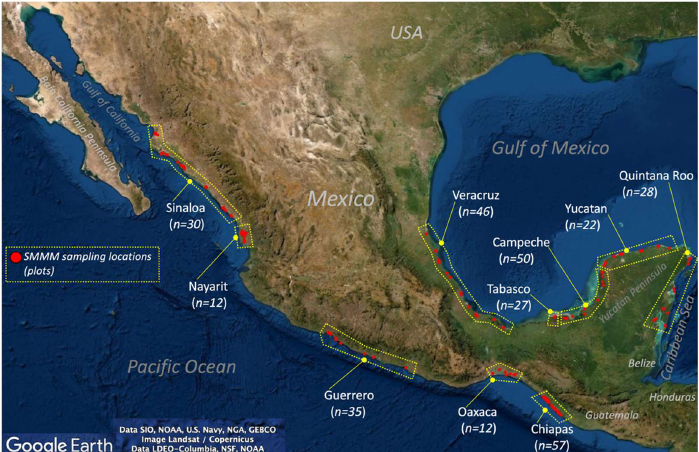
Figure 4. Location of sampling sites per coastal state (not to scale) where monitoring plots (400 m 2 ) were deployed in ten coastal states in the Eastern Pacific Ocean, the Caribbean Sea, and Gulf of Mexico basins; n = number of plots per state. See Table S1 for weblinks to data and information about geographical coordinates and mangrove forest structural data.